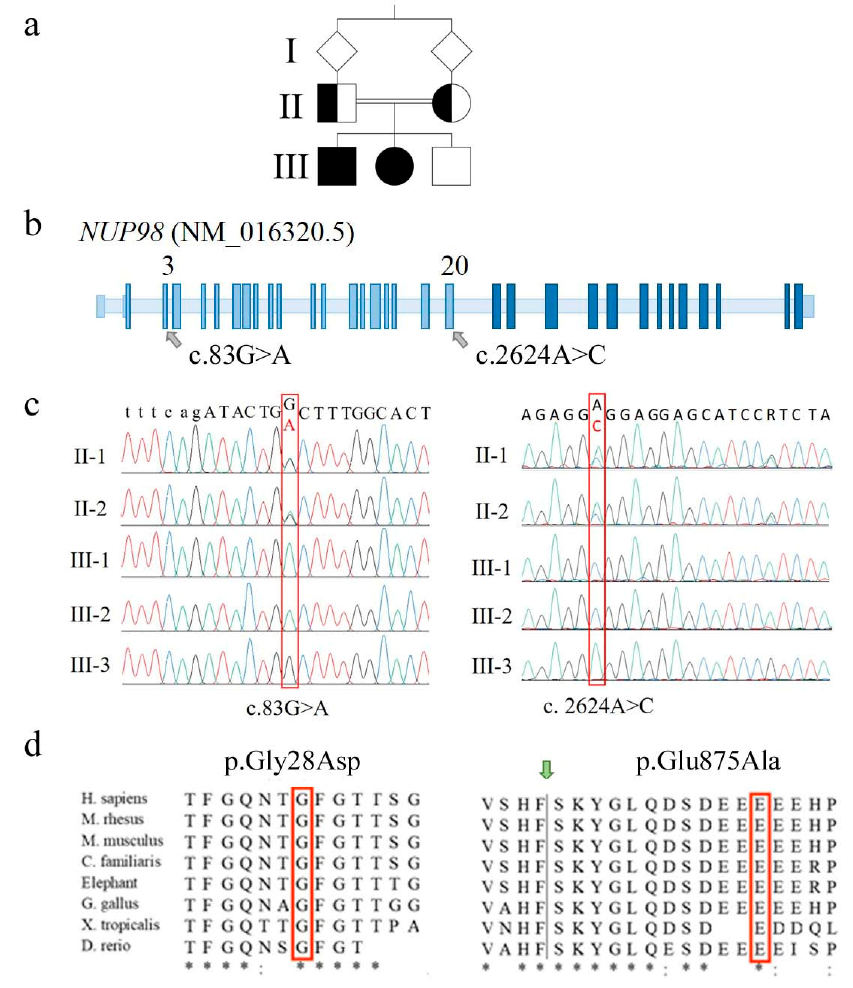
Figure 2. Molecular identification marks of NUP98 alterations detected in the family. ( a ) Pedigree of the family with two affected siblings (III-1 and III-2, filled square and circle) whose parents are first-cousins. ( b ) Positioning of the two identified NUP98 alterations onto the schematic genomic structure of the NUP98 gene (not in scale). Light blue boxes indicate exons coding for NUP98 protein while dark blue ones indicate exons coding for NUP96 protein. ( c ) Electropherograms showing the two alterations (red frame) identified in homozygous state in the affected siblings and in heterozygous state in the parents. To note, both variants are not detected in the healthy brother III-3, suggesting they are highly linked on the same allele (cis). ( d ) Phylogenetic conservation of the two fragments with the amino acid residues affected by the identified sequence changes in the red frame. Identical amino acids are asterisked; highly similar residues are indicated by semicolons. The green arrow indicates the auto-proteolytic cleavage site of the precursor protein allowing the separation of NUP98 from NUP96.